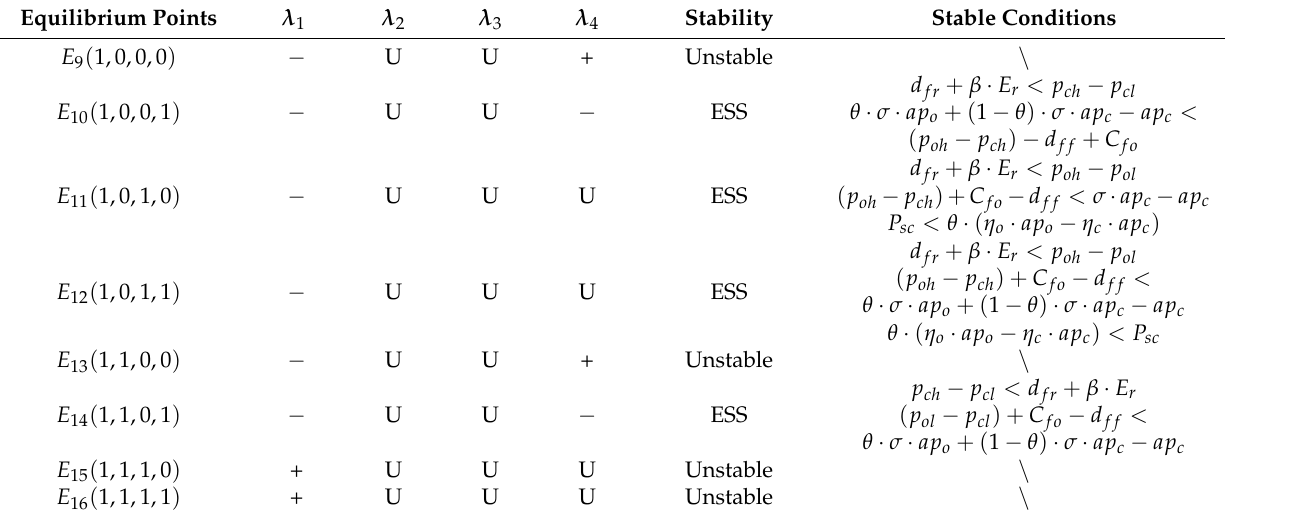
Table 5. Stability analysis of equilibrium points when local governments choose strict regulation ( g ). Stability Stable